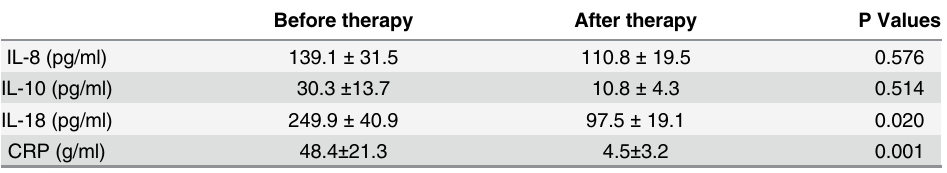
Table 2. Serum levels of IL-8, IL-10 and IL-18 of patients before therapy and after therapy. Before